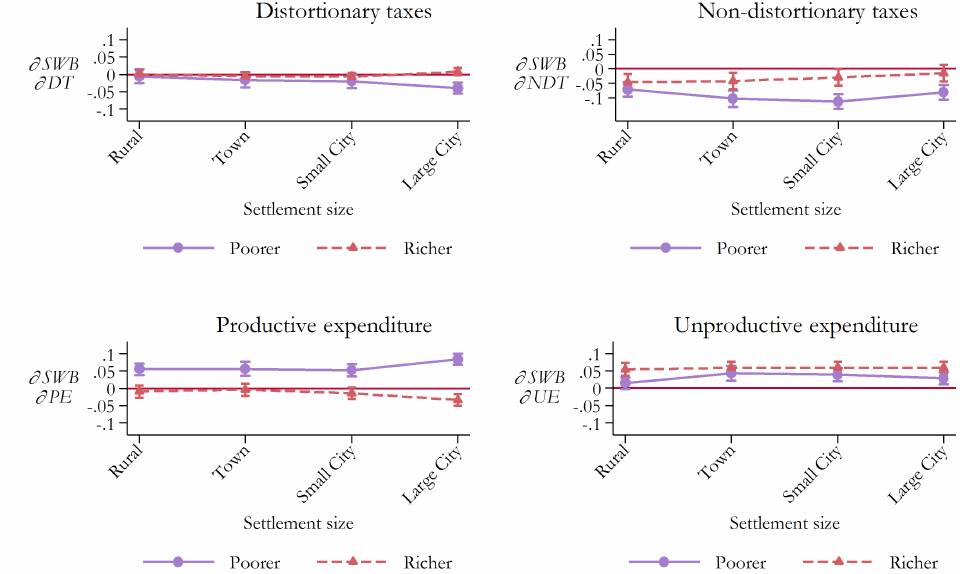
Figure 4: Marginal effects by settlement size and richer/poorer countries (90%